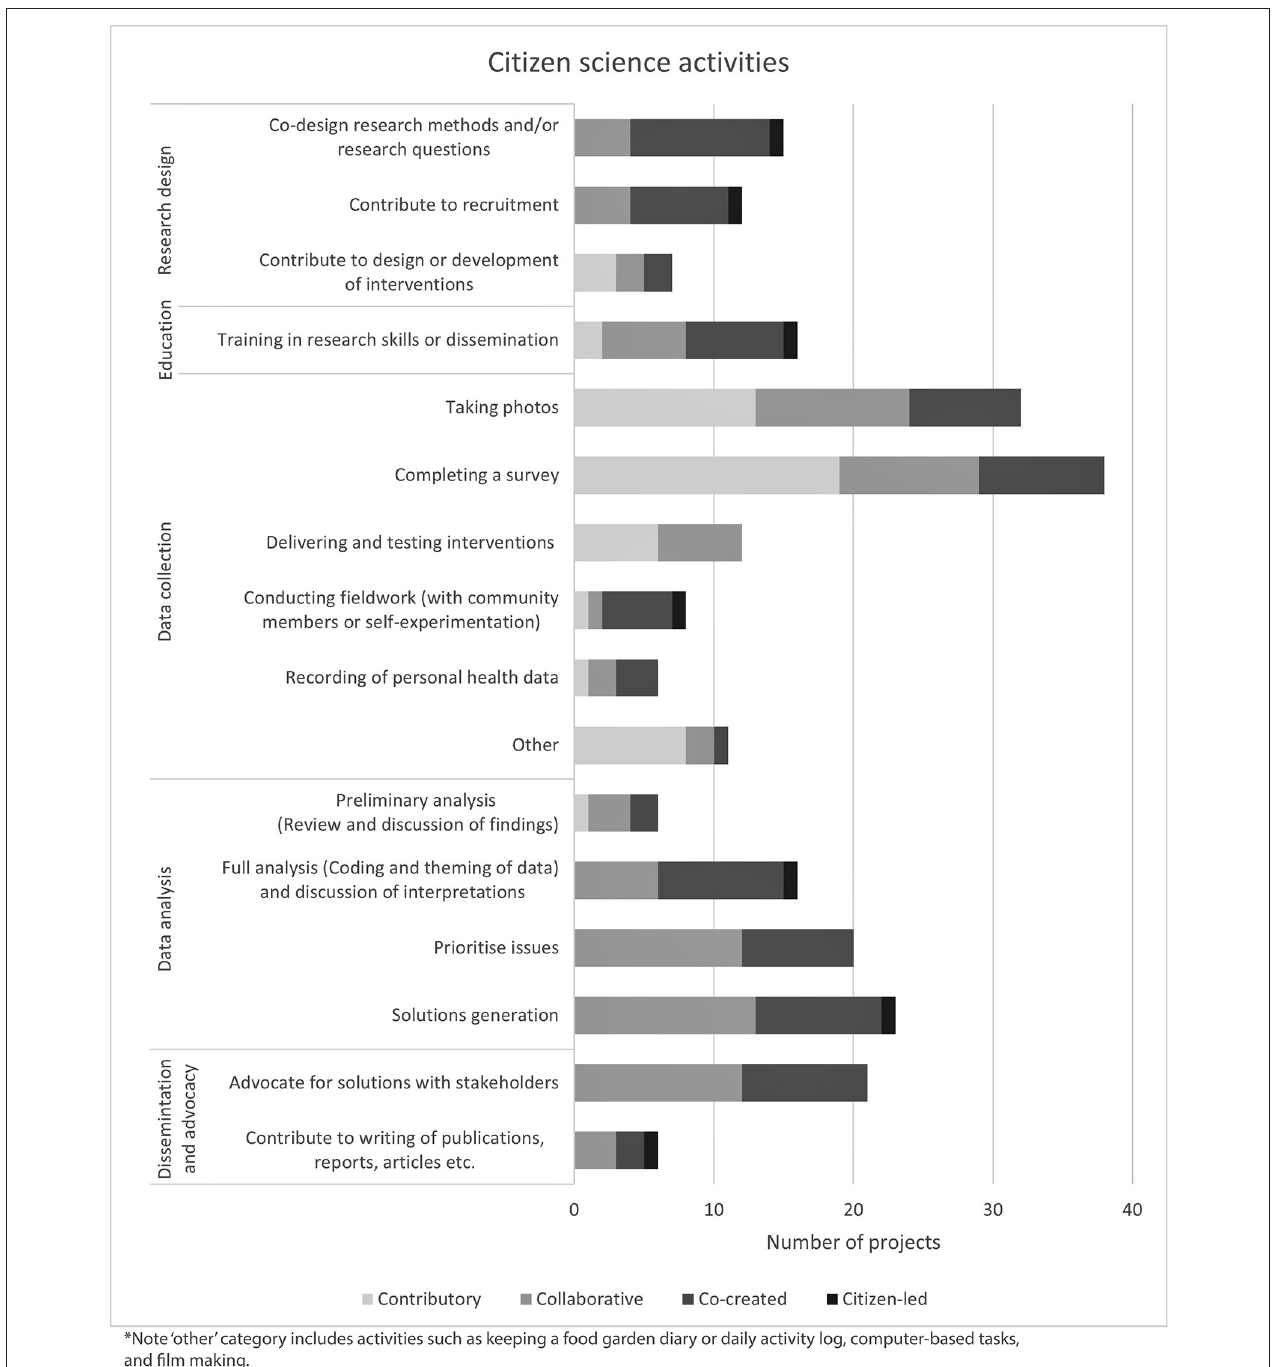
FIGURE 5 | Breakdown of activities performed by citizen scientists in citizen science projects ( n =